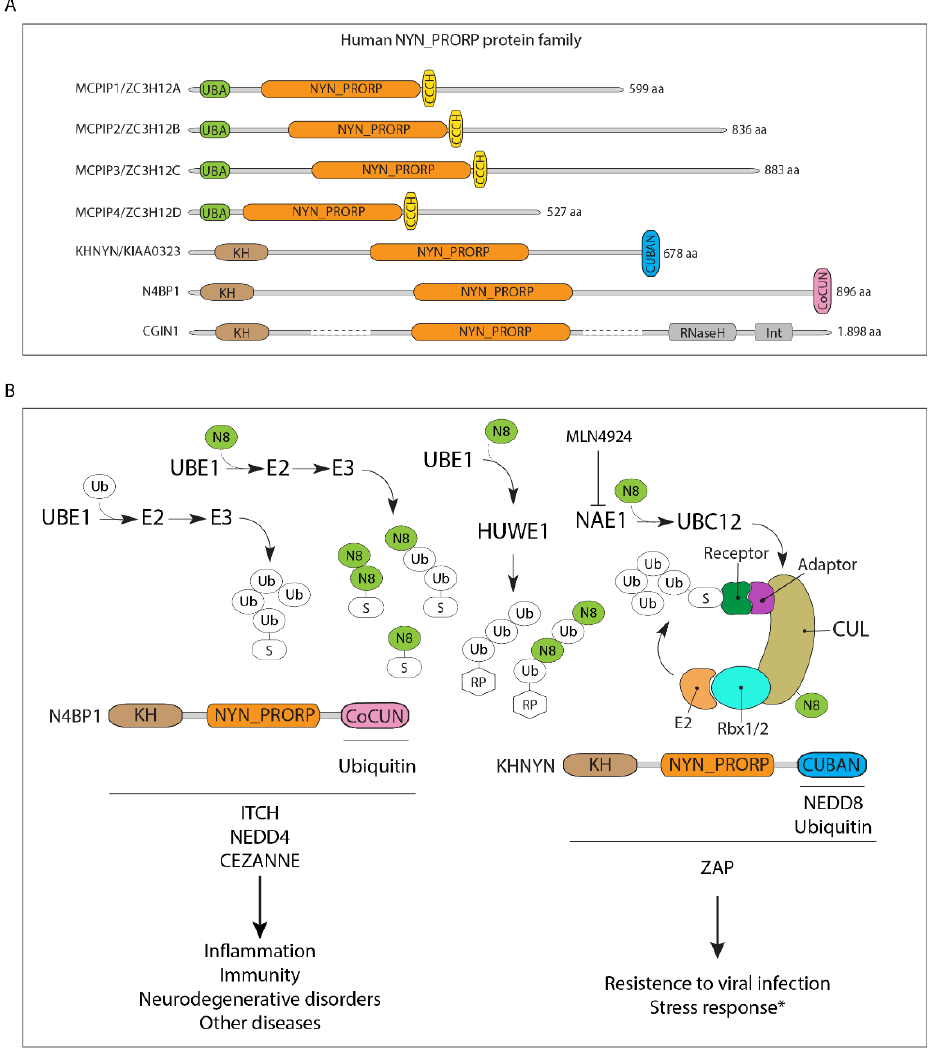
Figure 4. ( A ) Domain organization of human NYN_PRORP domain-containing proteins. ( B ) Protein–protein interactions and contextual network diagram of KHNYN and N4BP1 proteins. The ubiquitin E1 enzyme Ube1 mediates NEDD8 activation under diverse stress conditions. Modified neddylated proteins are simultaneously ubiquitinated. Upon proteotoxic stress the conjugation by the E3-ligase